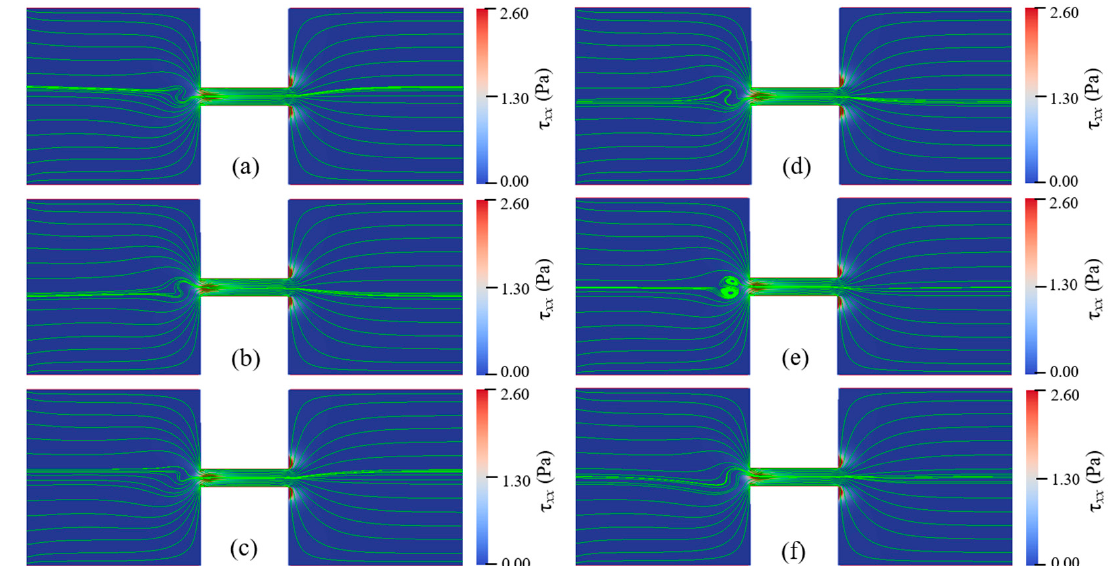
Figure 7. Instability of EOF with c p = 150 ppm and E app = 600 V/cm. Streamlines at different times: ( a ) 1.70 s, ( b ) 1.72 s, Figure 7. Instability of EOF with 𝑐 (cid:2926) = 150 ppm and 𝐸 (cid:2911)(cid:2926)(cid:2926) = 600 V/cm . Streamlines at different times: ( a ) 1.70 s, ( b ) 1.72 s, Figure 7. Instability of EOF with 𝑐 (cid:2926) = 150 ppm and 𝐸 (cid:2911)(cid:2926)(cid:2926) = 600 V/cm . Streamlines at different times: ( a ) 1.70 s, ( b ) 1.72 s, ( c ) 1.74 s, ( d ) 1.76 s, ( e ) 1.78 s, and ( f ) 1.80 s. The color bar represents the elastic normal stress τ xx . (Supplementary ( c ) 1.74 s, ( d ) 1.76 s, ( e ) 1.78 s, and ( f ) 1.80 s. The color bar represents the elastic normal stress 𝜏 (cid:3051)(cid:3051) . (Supplementary materials ( c ) 1.74 s, ( d ) 1.76 s, ( e ) 1.78 s, and ( f ) 1.80 s. The color bar represents the elastic normal stress 𝜏 (cid:3051)(cid:3051) . (Supplementary materials Materials Video S2). Video S2 ). Video S2 ).